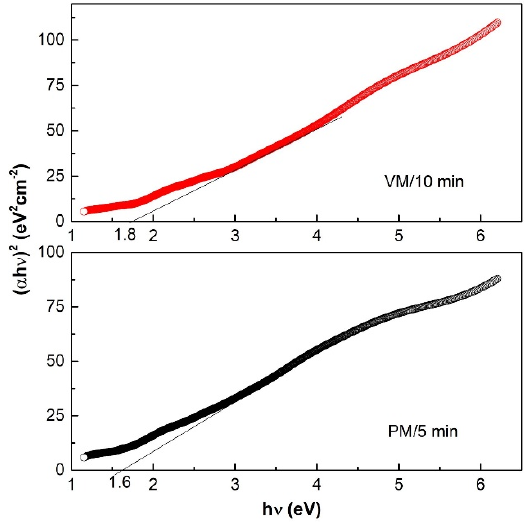
Figure 9. ( α h ν ) 2 vs. h ν plot and the obtained band gap energies, 1.6 and 1.8 Figure 9. (  h  ) 2 vs. h  plot and the obtained band gap energies, 1.6 and 1.8 eV.